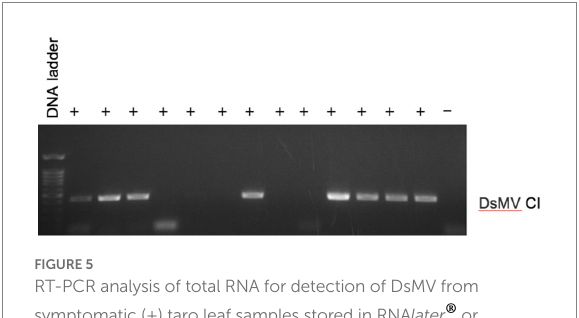
FIGURE 5 RT-PCR analysis of total RNA for detection of DsMV from symptomatic (+) taro leaf samples stored in RNA later ® or asymptomatic controls ( − ) using DsMV CI gene-specific